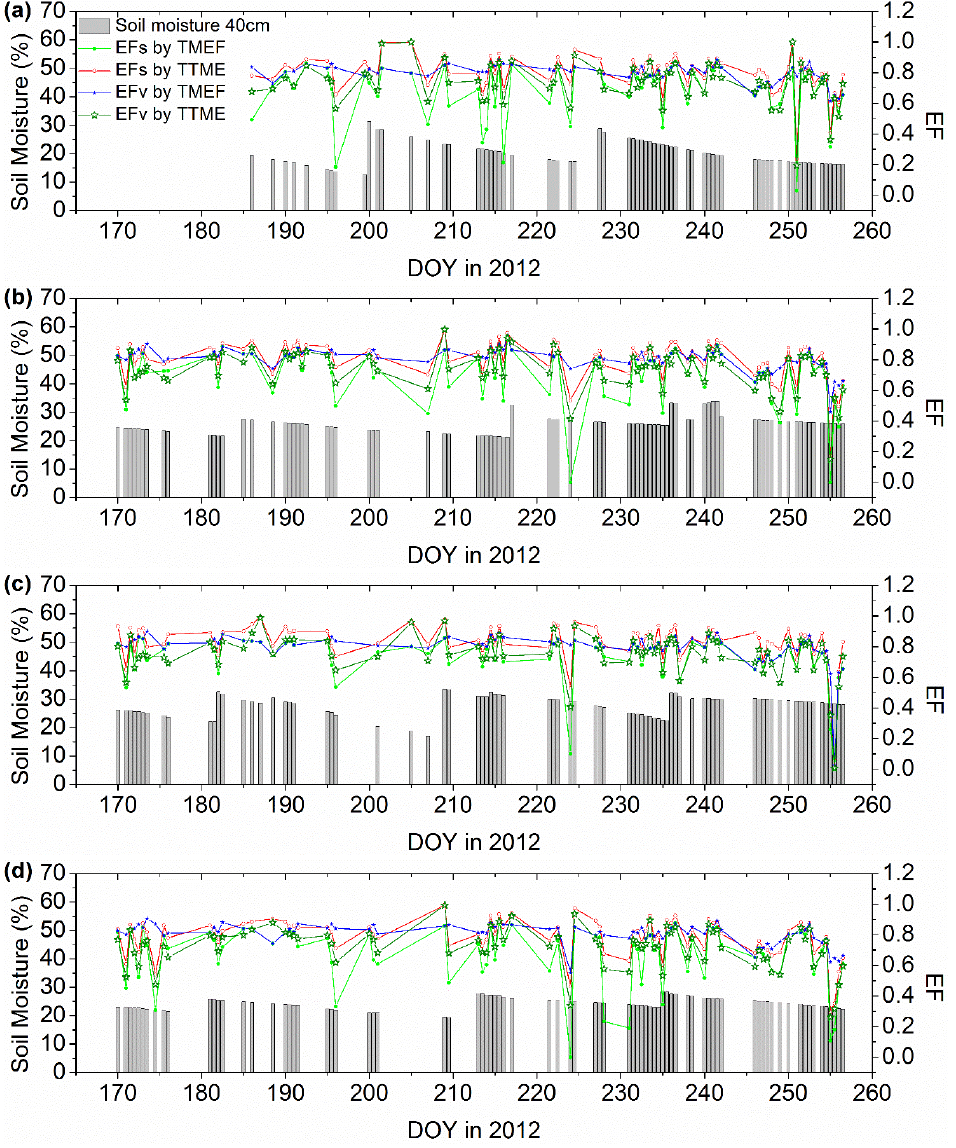
Figure 5. Comparison of estimated EFs and EFv between the TMEF and the TTME models at ( a ) No.11; ( b ) No.12; ( c ) No.13; and ( d ) No.14 stations. ( b ) No.12; ( c ) No.13; and ( d ) No.14